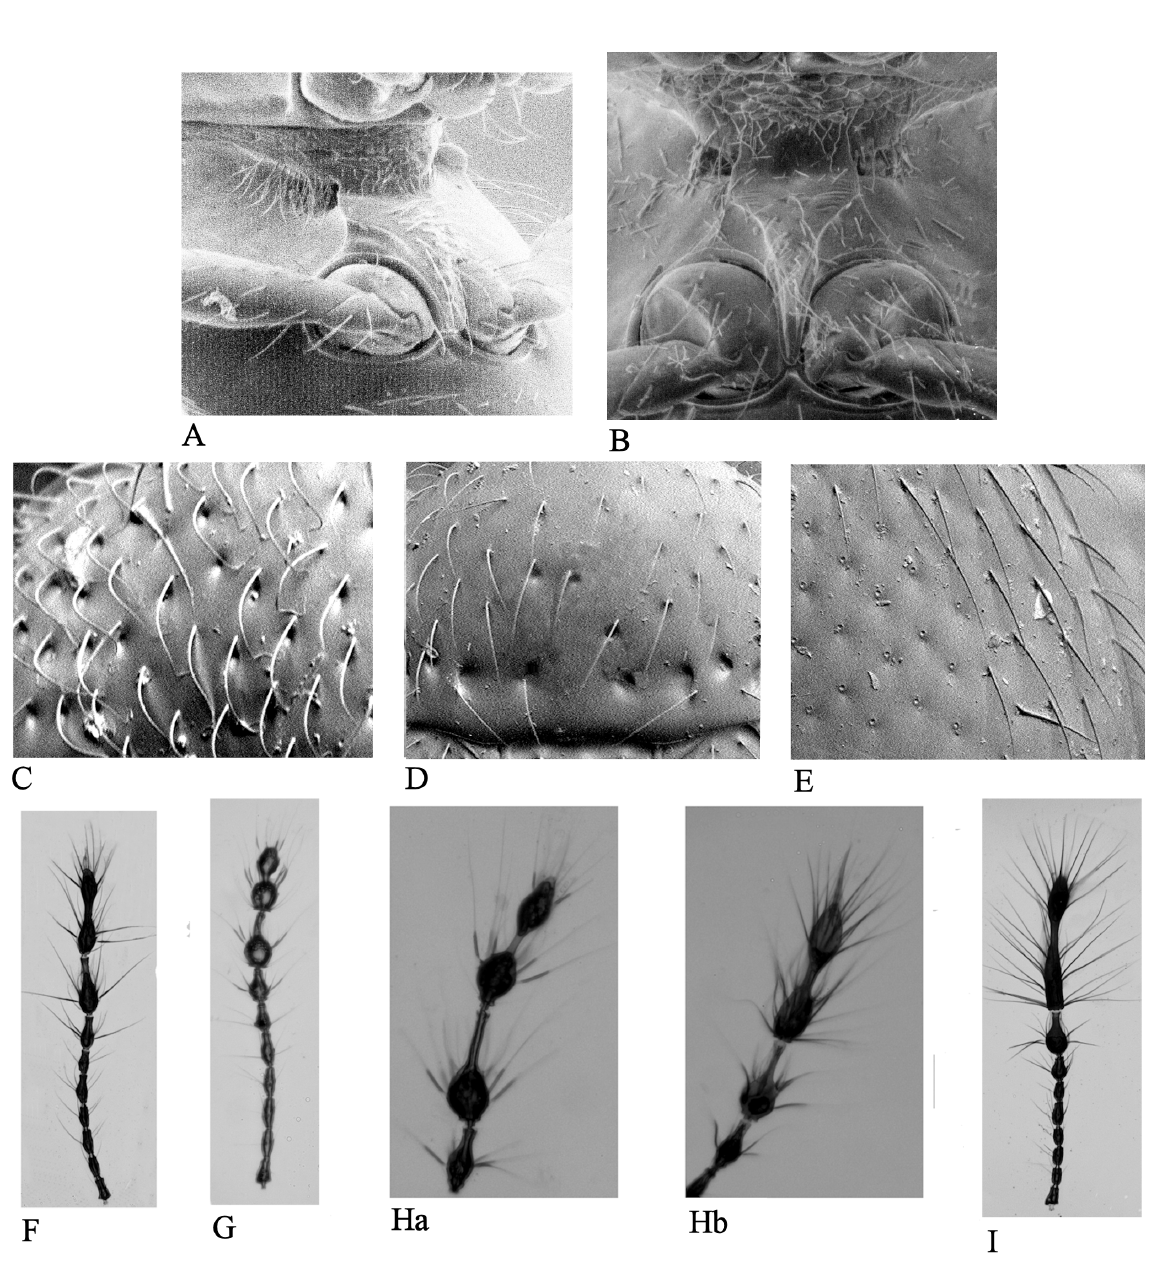
Fig. 2. A–B . Mesoventra of two species of Dacrysoma Grebennikov, 2009 to show form of mid-keel and perforation fringed by setae. C–E . Figures to explain use of the terms foveae, distinct foveolae and shallow foveolae in distinguishing the main species groups. C . Distinct foveolae, showing setae arising from the anterior margin of the depressions. D . Foveae and foveolae, showing setae randomly associated with foveae. E . Shallow foveolae, many setae rubbed off, but insertion points marked by punctures with slightly raised circular rims. F–I . Figures to show different forms of antennae. F . Elongate antenna of Cissidium lisae Darby, 2015. G . Globular antennomere of Cissidium globosum Darby, 2015. H . Female and male antennae of Cissidium petri Darby, 2015. I . Abnormal antennomere XI of Cissidium tigrum Darby,